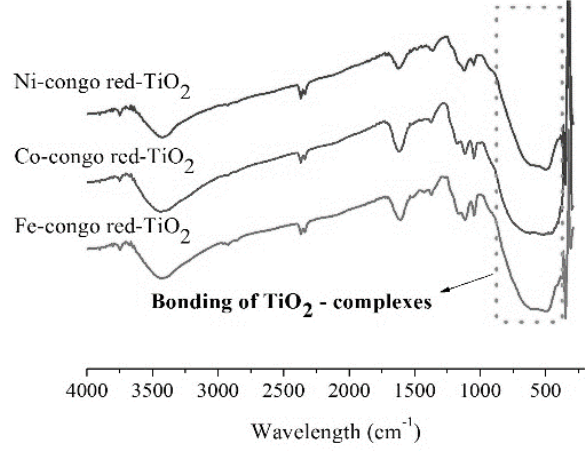
bonding with congo red 2